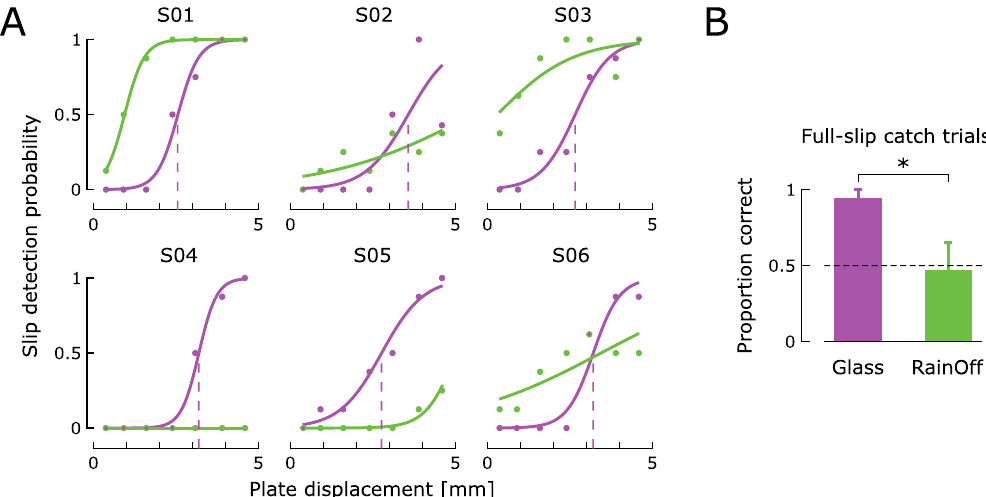
Figure 3. Experiment 2: Impaired slip detection in the low-friction condition. (A) Answers from all six subjects plotted against PD for the high- (purple) and low- (green) friction conditions. Subjects perceived fingertip slip consistently in the high-friction condition. However, in the low-friction condition, most subjects reported that they were not able to detect slippage and therefore answered randomly. Purple and green dots correspond to the average of all trials sharing the same PD within the corresponding condition. They are displayed for illustrative purposes only; psychometric curves were fitted on data from individual trials. (B) Results from full-slip catch trials. Bar graphs summarize the ability of subjects to detect fingertip slip when the plate was fully slipping under their fingertip. Data are displayed as the mean proportion of correct answers ± standard error across subjects. In the high-friction condition (glass), subjects’ performance was above 95%. In contrast, detection accuracy decreased to 47% (near the 50% chance level, dashed line) in the low-friction condition (RainOff), effectively reflecting the inability of subjects to detect slippage in this